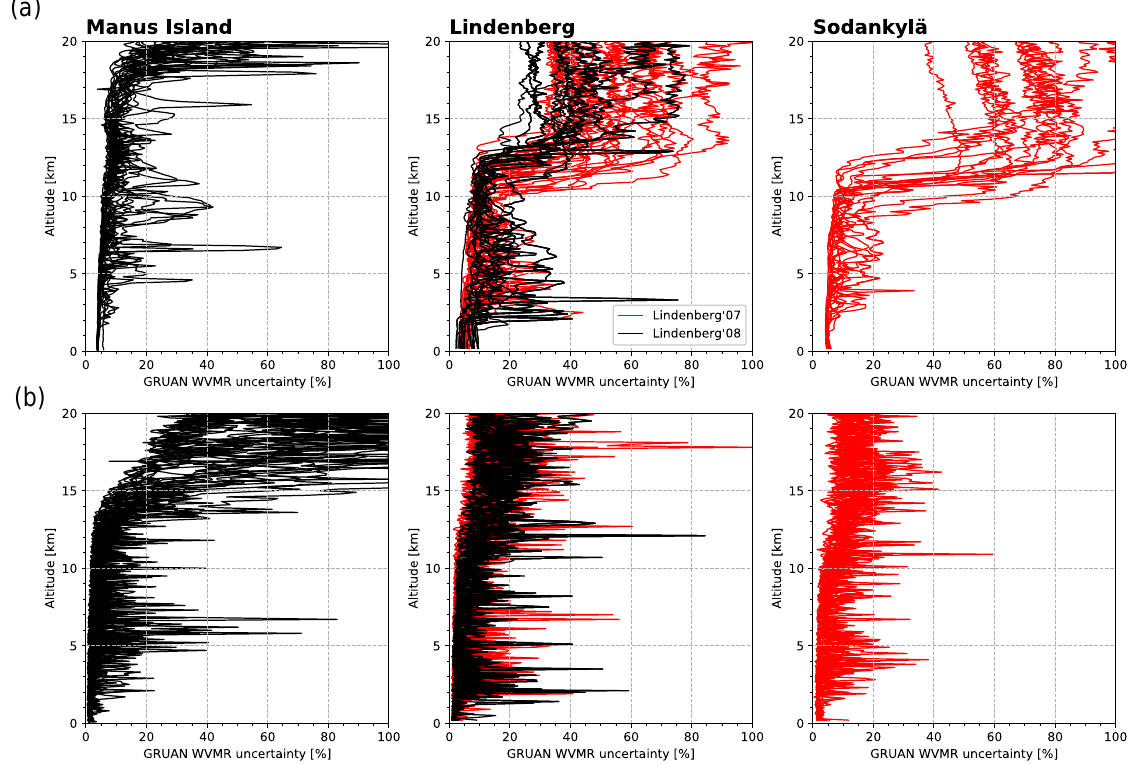
Figure A1. Profiles of the WVMR errors of the GRUAN radiosondes: panel (a) represents the correlated errors and panel (b) the uncorrelated errors. The colours distinguish between the different ensembles of the retrieval set-up: black for MI and LI08, and red for LI07 and SK07.